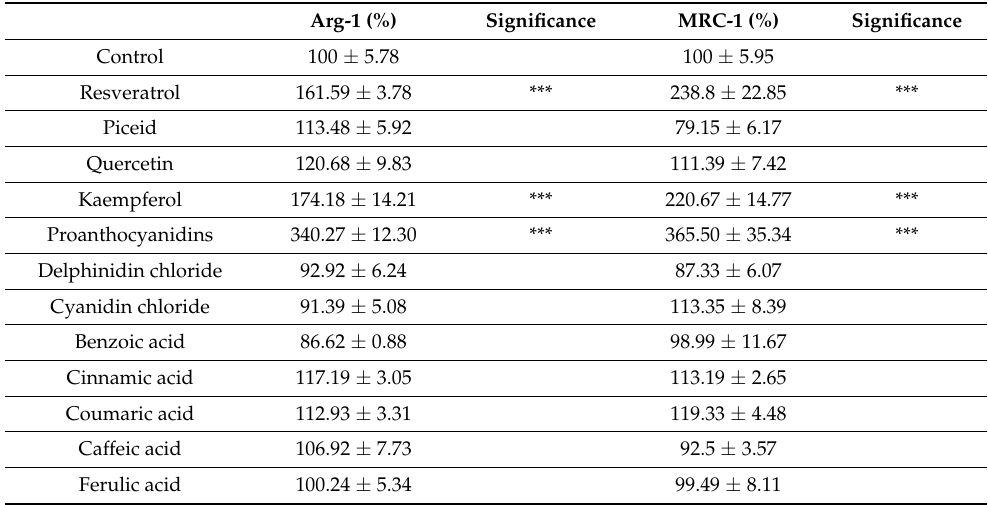
Table 1. Effects of the twelve phenolic compounds (at 30 µ M concentrations) on M2-type activation in murine J774